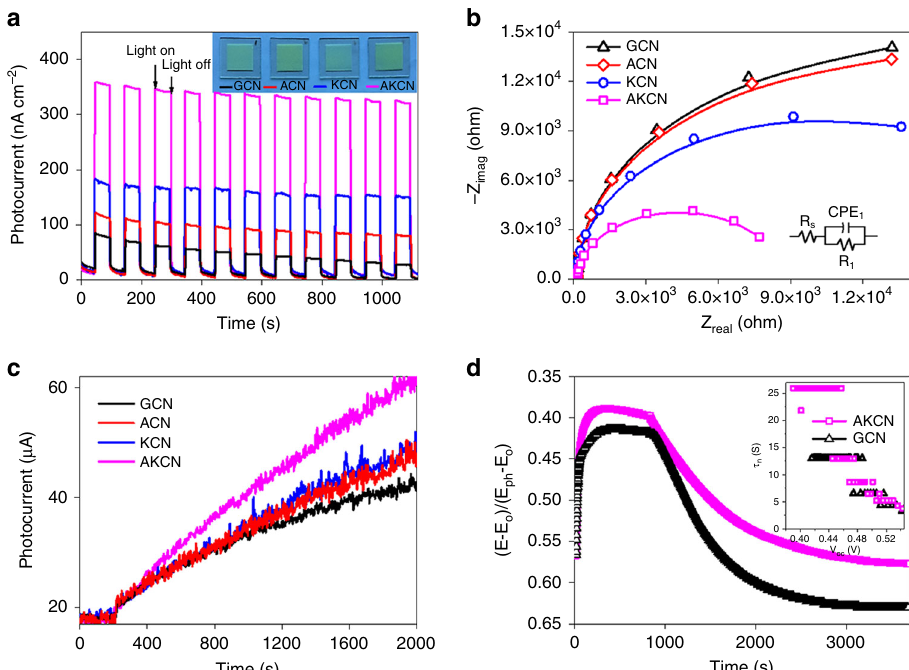
Fig. 4 Photoelectrochemical behaviours of pure and modi fi ed GCN. a Transient photocurrent responses (inset: images of different electrodes). b Electrochemical impedance spectra (EIS). In the simulated electrical equivalent-circuit model (inset), R S , R 1 , and CPE represent as solution resistance, charge transfer resistance, and double layer capacitance, respectively. c Time pro fi les of Fe 3 + /2 + -redox shuttle-mediated photocurrent collected on a Pt electrode in the catalyst suspension. d Open-circuit voltage decay (OCVD) measurement (inset: average lifetimes of the photogenerated carriers as a function of the V oc ). The black open-triangle and pink open-square represent the GCN and AKCN, respectively. Source data are provided as a Source Data fi le